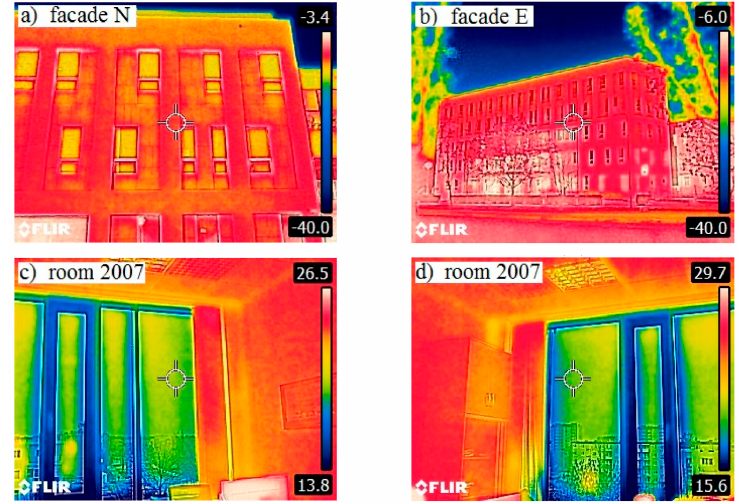
Figure 4. The courthouse: thermal images of the Northern ( a ) and Eastern ( b ) façades as well as room 2007 on the second floor ( c , d ).